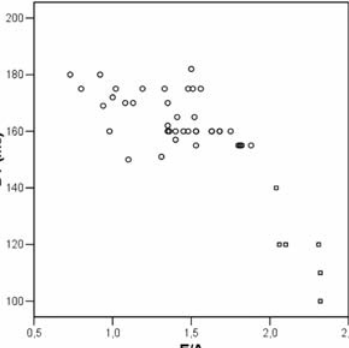
Figure 1 Scatter plot of base- line values of deceler- ation time of right ventricular early fill- ing (DT) and peak early to peak late right ventricular filling velocity (E/A). Patients with right ventricular restrictive filling pattern are plotted with square symbols.